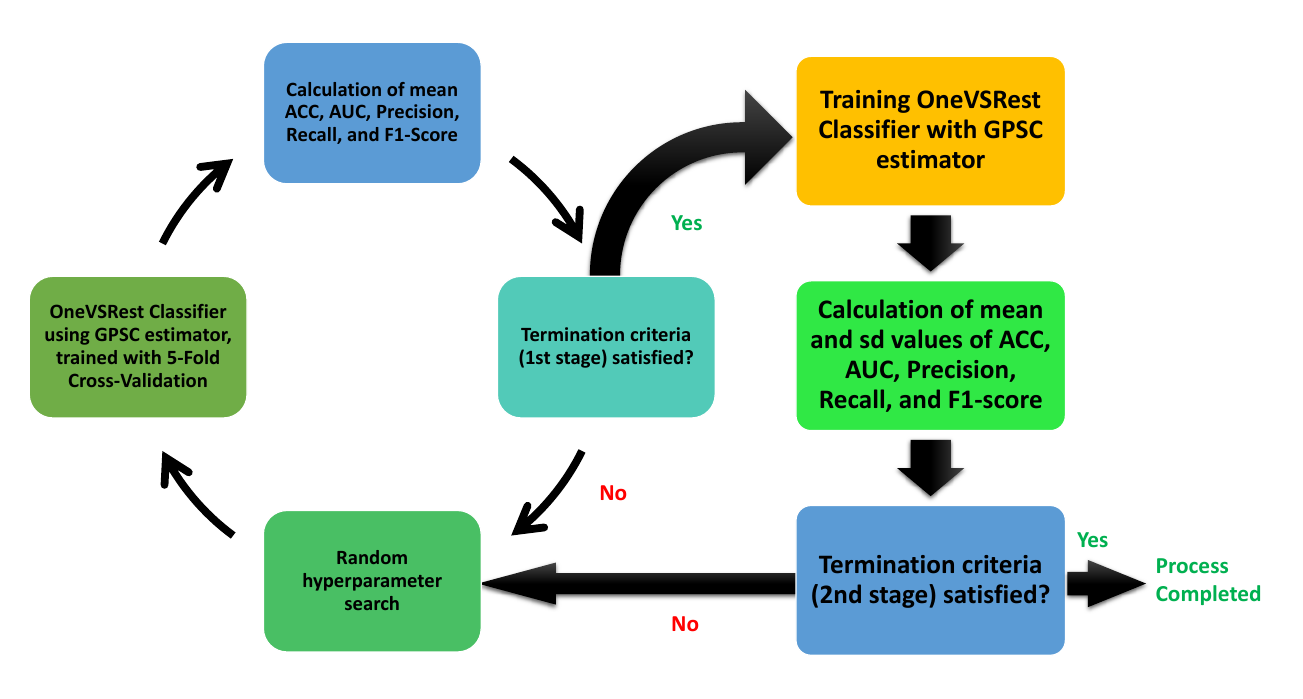
Figure 6. The GPSC algorithm with random hyperparameter search with 5-fold